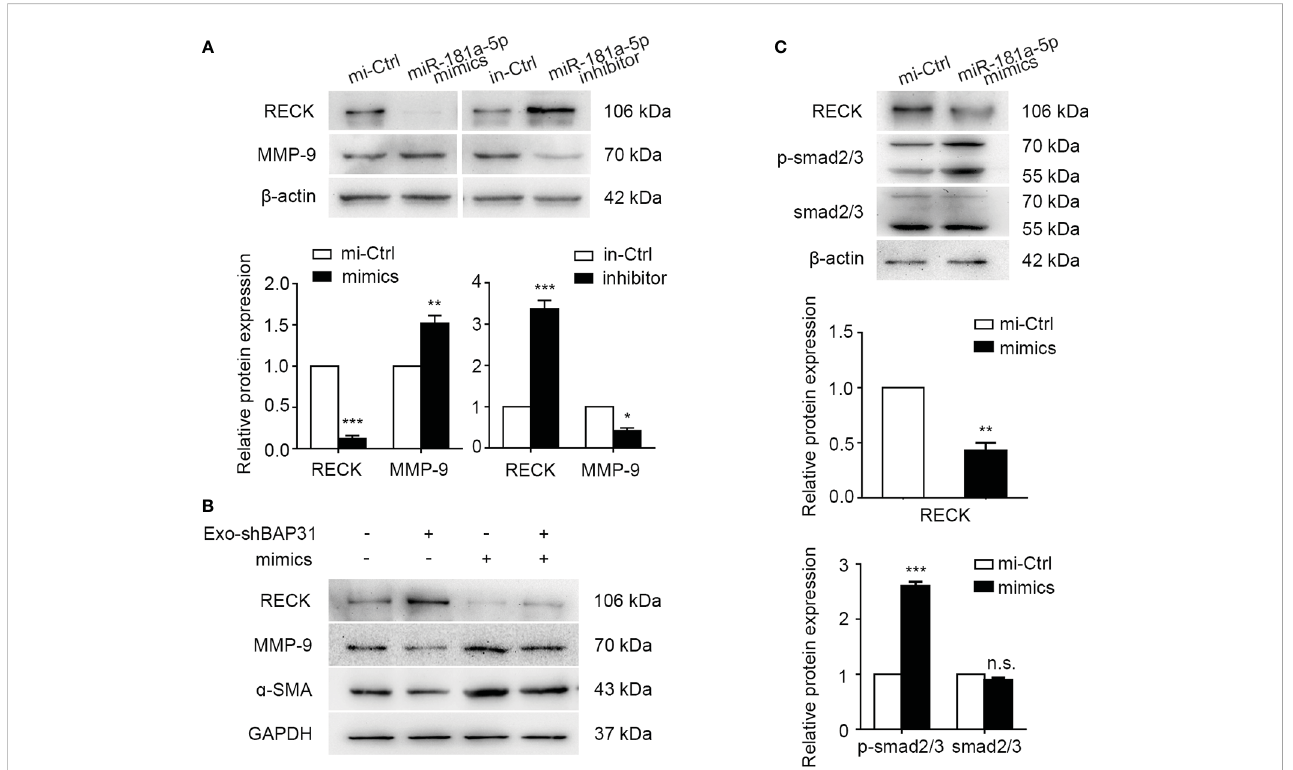
FIGURE 6 miR-181a-5p activated fi broblasts by upregulating MMP-9 and phosphorylation of smad2/3. (A) Western blot analysis shows the expression of RECK and MMP-9 in fi broblasts transfected with miR-181a-5p mimics/inhibitor. Mean ± SEM are provided (n = 3). * p < 0.05, ** p < 0.01, and *** p < 0.001. Fibroblasts were transfected with miR-181a-5p mimics or treated by exosomes from BAP31-knockdown CRCs. (B) Western blot analysis shows the expression of RECK, MMP-9, and a -SMA in the fi broblasts. (C) Western blot analysis shows the expression of the phosphorylation of Smad2/3 in fi broblasts. Mean ± SEM are provided (n = 3). ** p < 0.01 and *** p < 0.001; n.s., non-signi fi